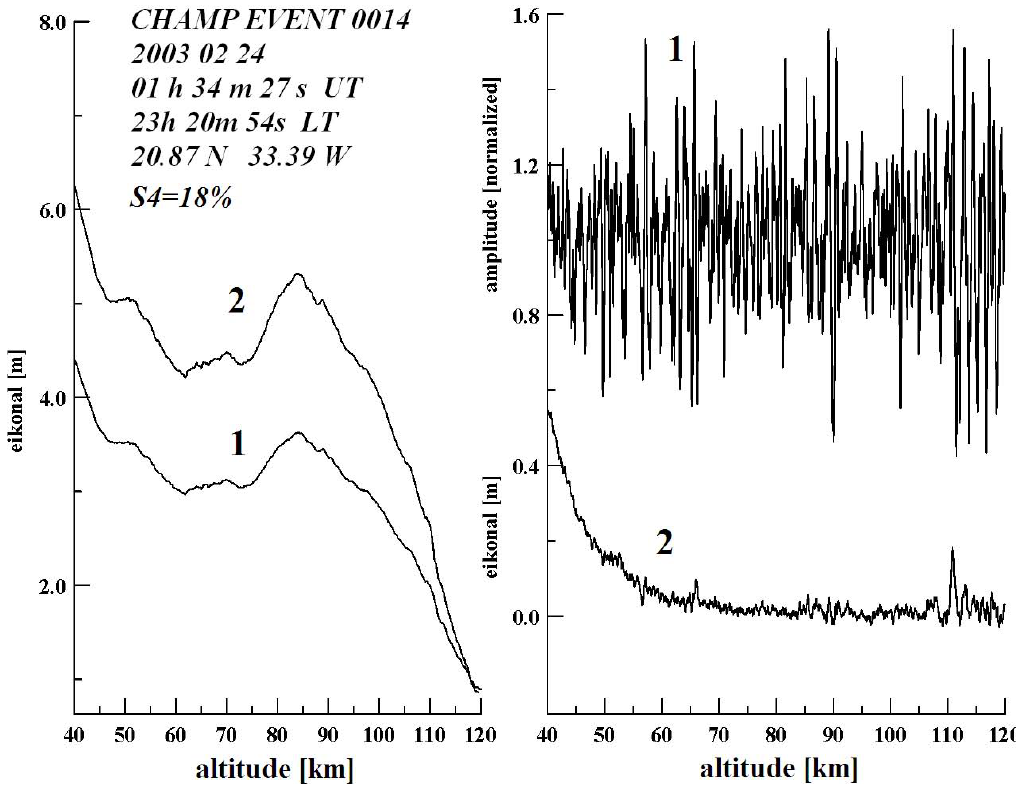
Fig. 5. Amplitude and phase values of the CHAMP RO signal for noisy events no. 0014, 24 February 2003 near the geomagnetic equator at local night. (Left) Eikonal variations at frequencies f 1 and f 2 (curves 1 and 2, respectively). (Right) Amplitude variations at frequency f 1 (curve 1) and the combined eikonal 8(t) (curve 2).